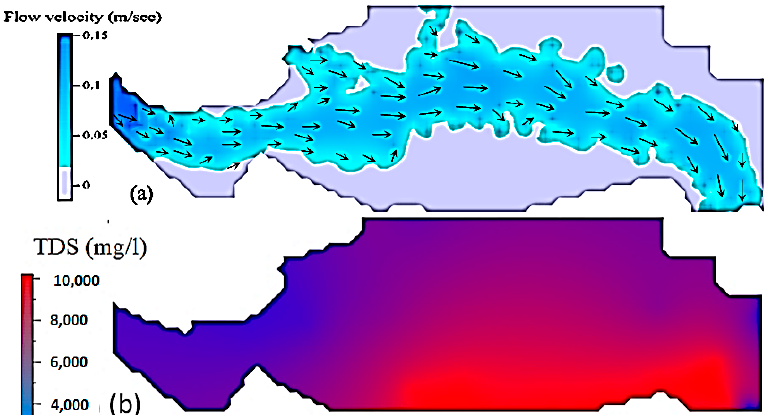
Figure 7. Distribution patterns of the flow velocity and TDS for the minimum inflow (Case 30). ( a ) Velocity pattern. ( b ) TDS pattern.